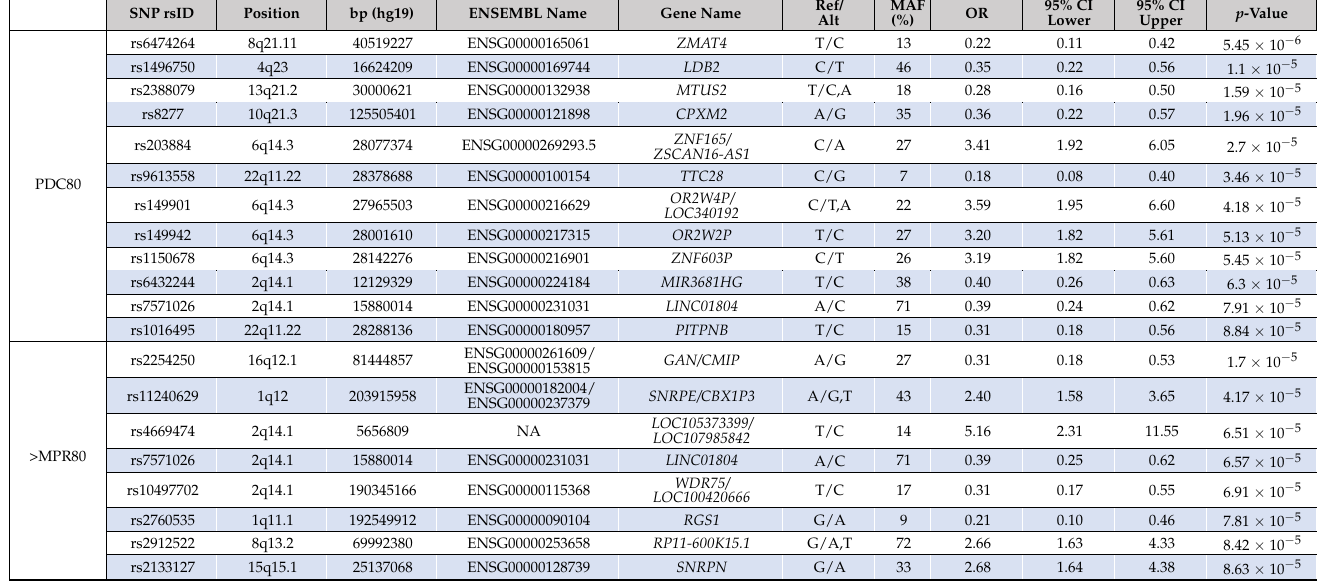
Table 2. Significant and Nominally Significant SNPs in PDC80 and